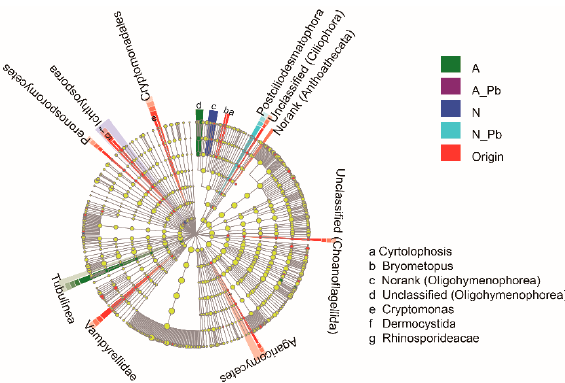
Figure 3. Linear discriminant analysis effect size (LEfSe) cladogram of fungal communities before and after exposure to ALAN and/or Pb. Treatment abbreviations are defined in Figure 1.